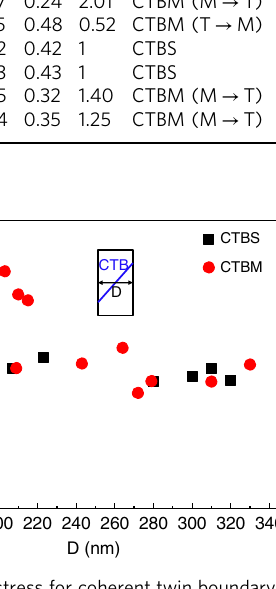
Table 1 Schmid factors and deformation mechanisms in nano-twinned Cu pillars Initial pillar orientation